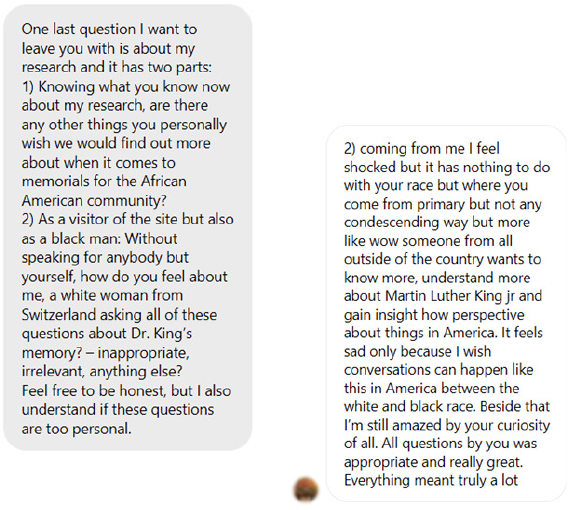
Figure 7. The role of the